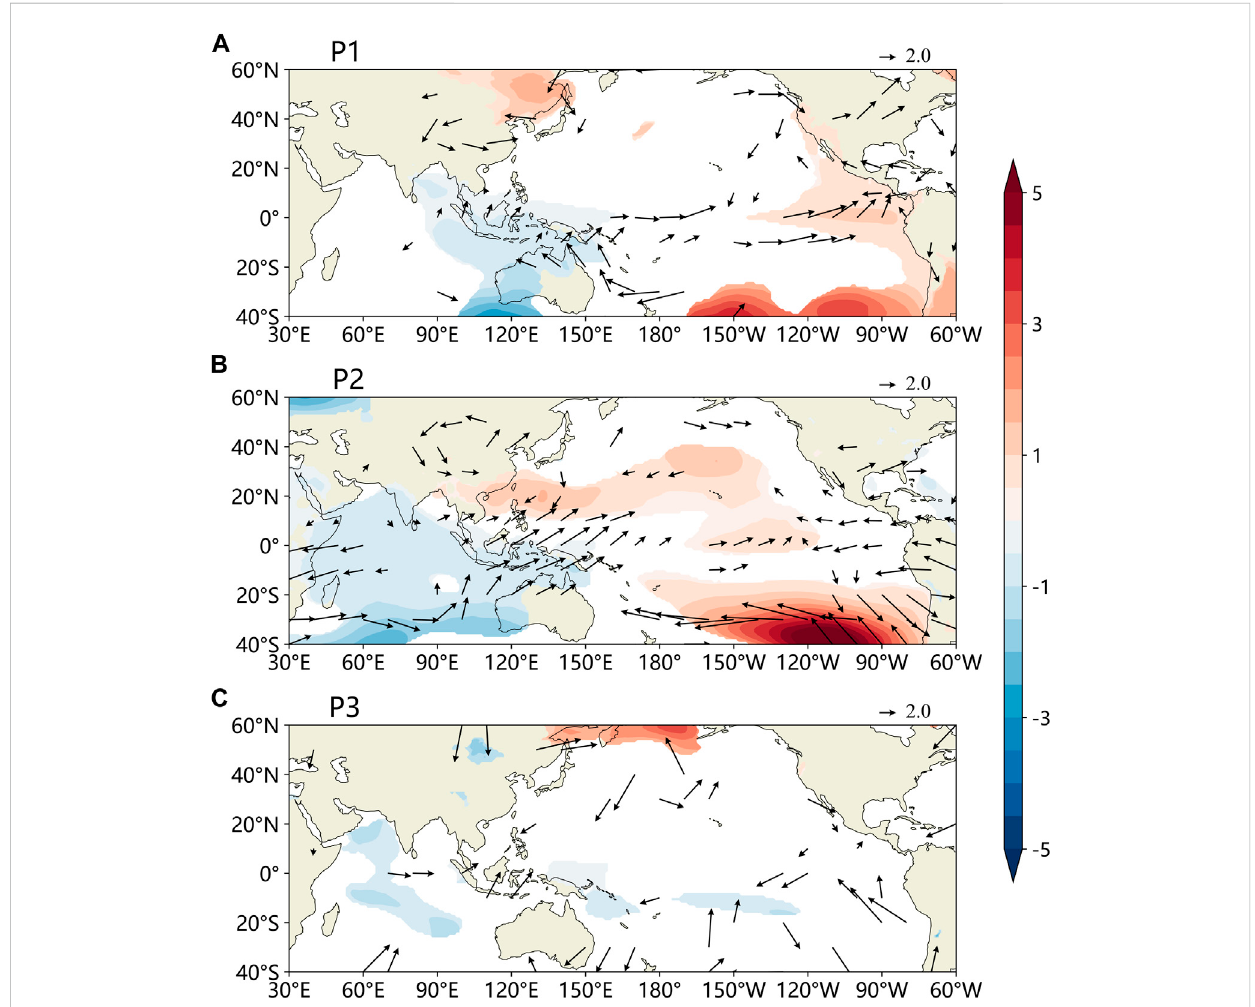
FIGURE 8 Regression coef fi cient of the previous autumn IOD index projected to the sea level pressure anomalies (shadows; Unit: hPa) and 200 hPa wind anomalies (vector; Unit: m/s) in the summer during (A) P1, (B) P2 and (C) P3.